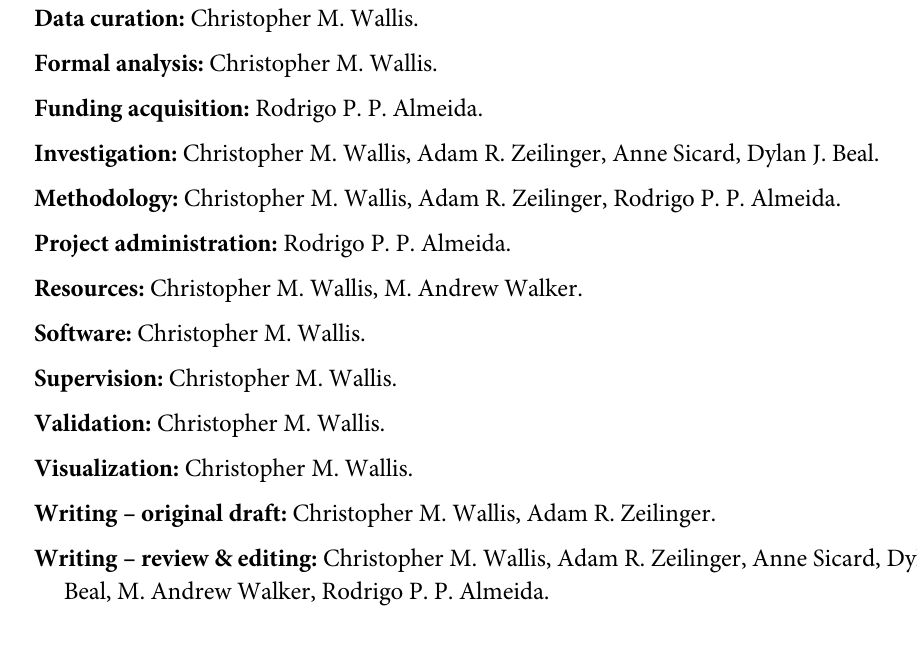
S2 Table. Analyses of individual compounds in woody tissues of susceptible and resistant grapevines over time. Woody tissue compound mean ( ± SE) levels ( μ g / g FW) for each treat- ment combination (phenotype by inoculation treatment) per each week individually. ANOVA statistics are provided, as well as a description of significant effects or LSD separations. HCAs = hydroxycinnamic acid derivatives; CATs = catechins; PROs = procyanidins; FLAVs = flavonoids; STILLs = stilbenoids; Res = resistant genotype; Sus = susceptible genotype; None = non-infected controls; Mock = mock-inoculated plants; Xf = X. fastidiosa infected